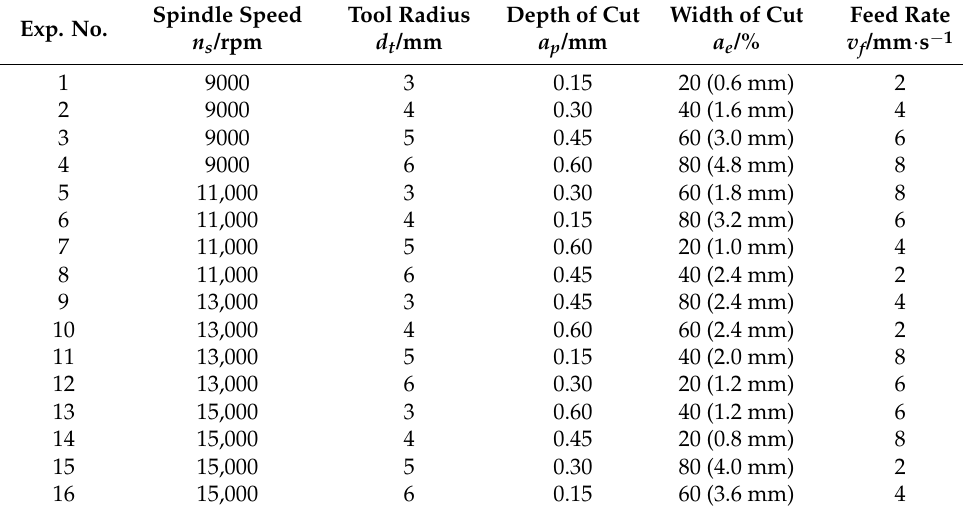
Table 2. Orthogonal factorial experiment design: L16(4 5